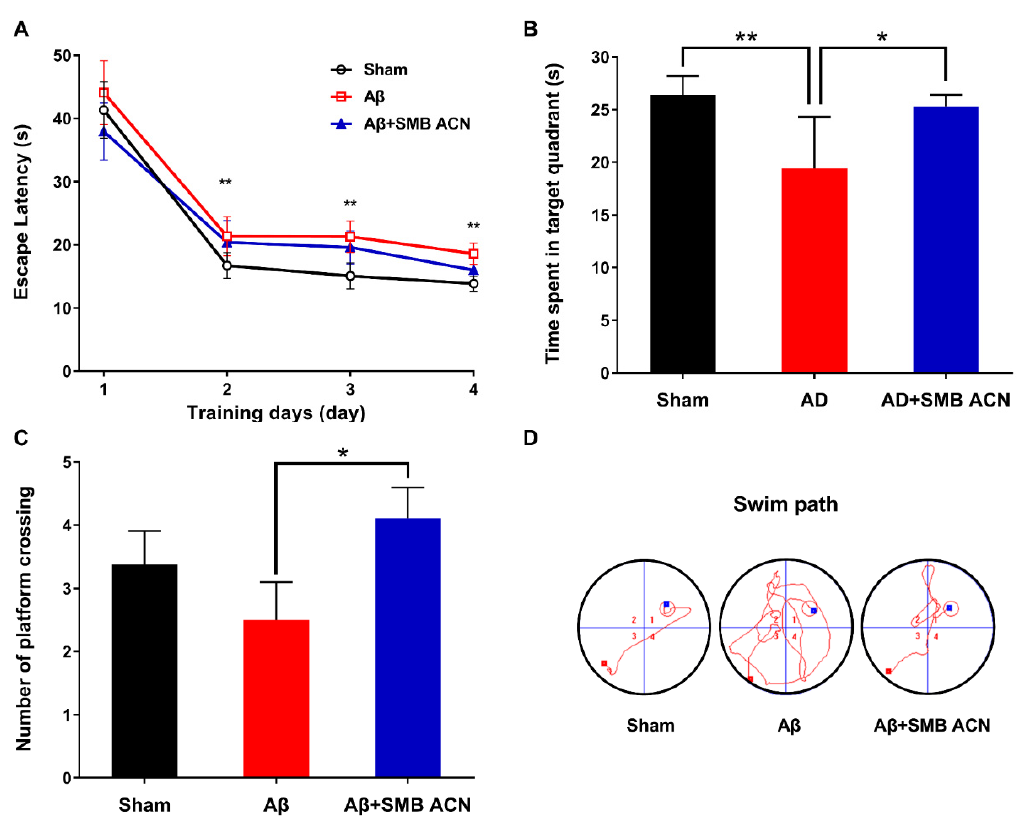
Figure 5. SMB ACN treatment alleviated A β induced spatial learning deficits. ( A ) The escape latency during the spatial acquisition trials of Sham, A β and A β + SMB ACN group; ( B ) The time spent in the target quadrant of the spatial probe test; ( C ) The number of platform crossing of the spatial probe test; ( D ) The swim path of the spatial acquisition trial. The results were expressed by mean ± SD ( n = 12) and the * p < 0.05, ** p < 0.01 by LSD test of one-way ANOVA.